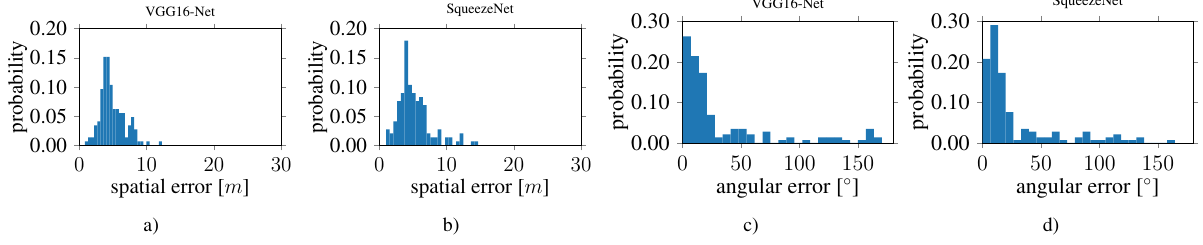
Figure 7. Medium coverage sequence . The histograms show the spatial and angular errors of the CNN derived poses to ground truth. Whereas a) and b) depict the spatial errors of our VGG16-Net respectively SqueezePoseNet and c) and d) show the angular